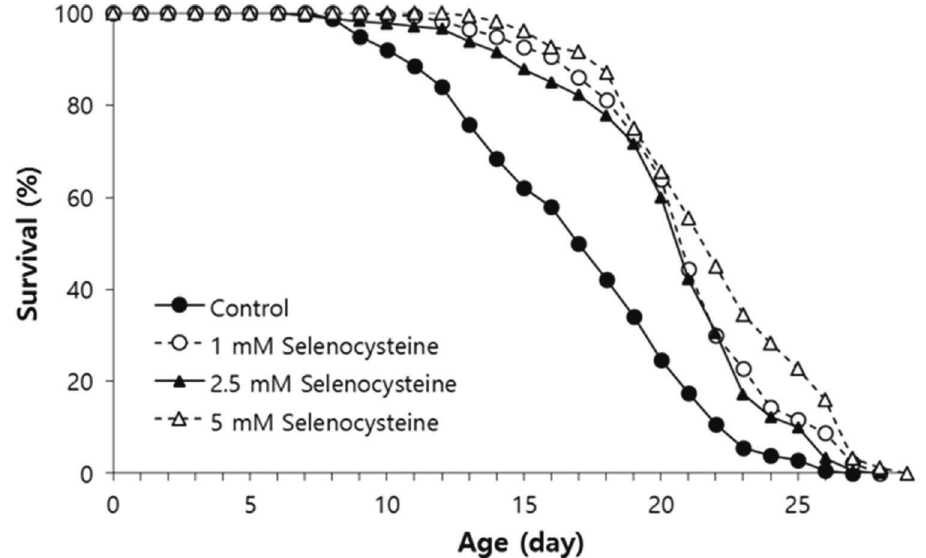
Figure 3 - Lifespan-extending effect of selenocysteine. Age-synchronized young adult worms (n=60) were transferred to NGM plates containing differenct concentrations of selenocysteine, and the number of alive/dead worms was recorded every day. Worms that were lost or showed internal hatching during the assay were excluded. For all concentrations of selenocysteine tested, the mean lifespan was markedly increased compared with that of the untreated control ( p o 0.05).